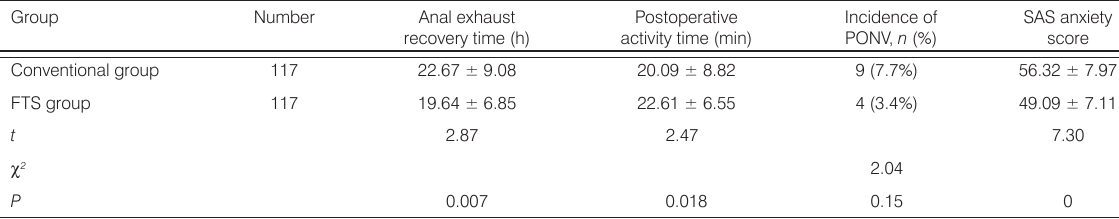
Table 2. Study outcomes in two groups of